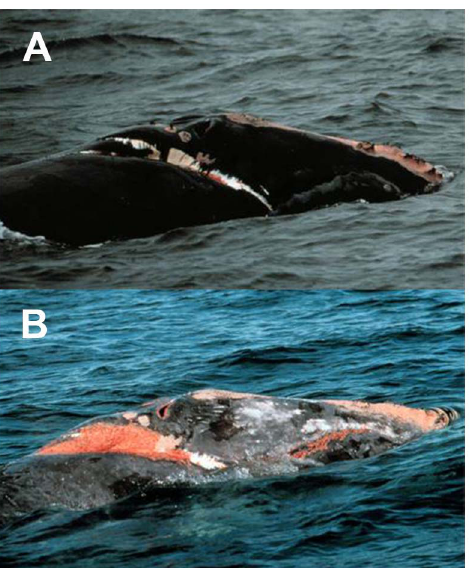
Figure 3. Visual health parameters. Photo plate depicting whale # 1621, an adult male last seen in 2000. Photo in panel a) was taken in 1997, and panel b) was taken in 1999. Photos show examples from four of the visual health parameters: 1) entanglement severity, 2) presence of orange cyamids around the blowholes, 3) poor skin condition, and 4) rake marks forward of the blowholes. There are multiple ordinal classes within each health parameter. For example, in a) skin condition received a score of 2– good skin condition, while in b) skin condition would receive a score of 1– poor skin condition.